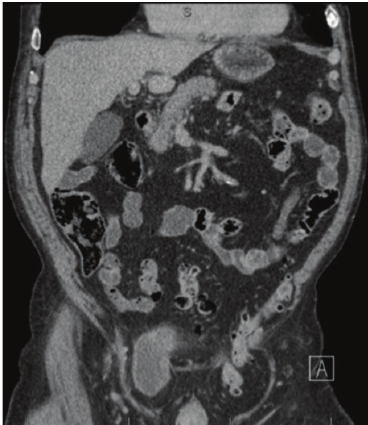
Figure 2: Coronal view of herniated bladder containing transitional cell carcinoma.